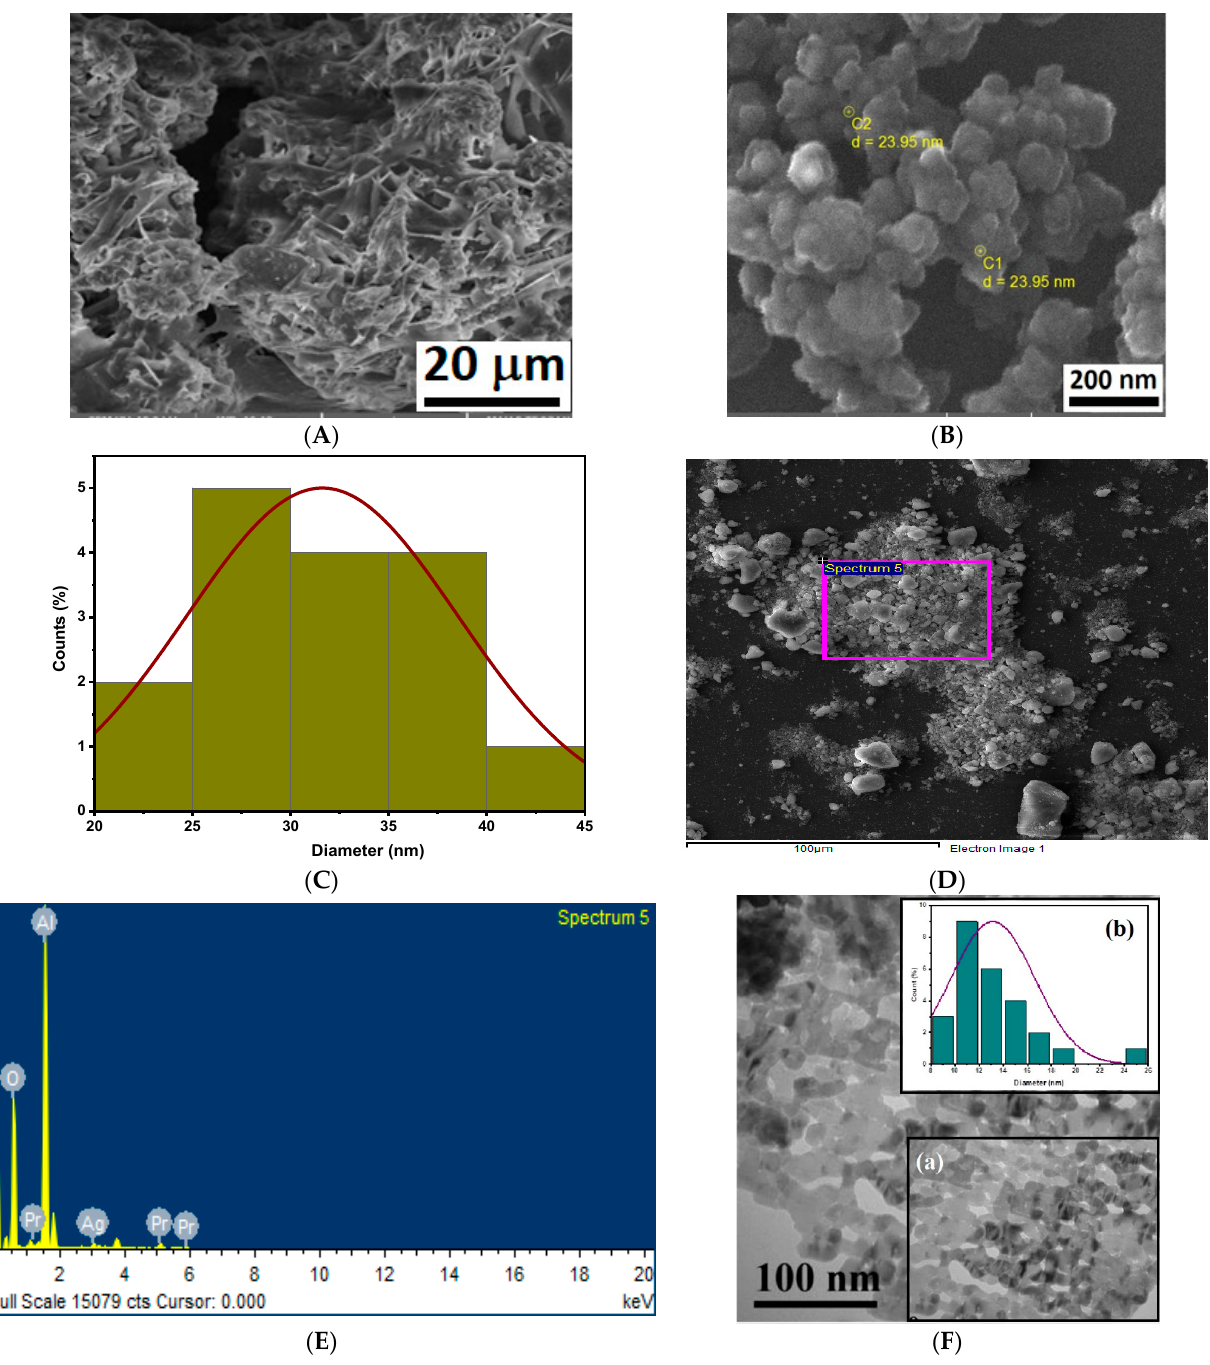
Figure 4. SEM micrographs for ( A ) Al 2 O 3 and ( B ) Ag 2 O (10) / γ -Al 2 O 3 nanocatalysts. ( C ) Particle size distribution of Ag 2 O (6) –PrO 2(4) / γ -Al 2 O 3 . ( D , E ) EDX spectrum of Ag 2 O (4) –PrO 2(6) / γ -Al 2 O 3 composition. ( F ) TEM analysis of sample Ag 2 O (2) –PrO 2(8) / γ -Al 2 O 3 , the inset (a) describes the area where distribution of particles taken and inset (b) represents the distributions of particles.